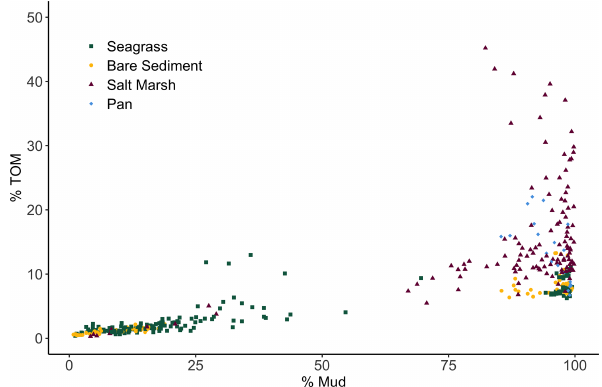
Figure 4. Biplot showing the relationship among total organic ma- terial (TOM) (%) of each 2cm core section from each habitat type plotted against sediment grain size (%